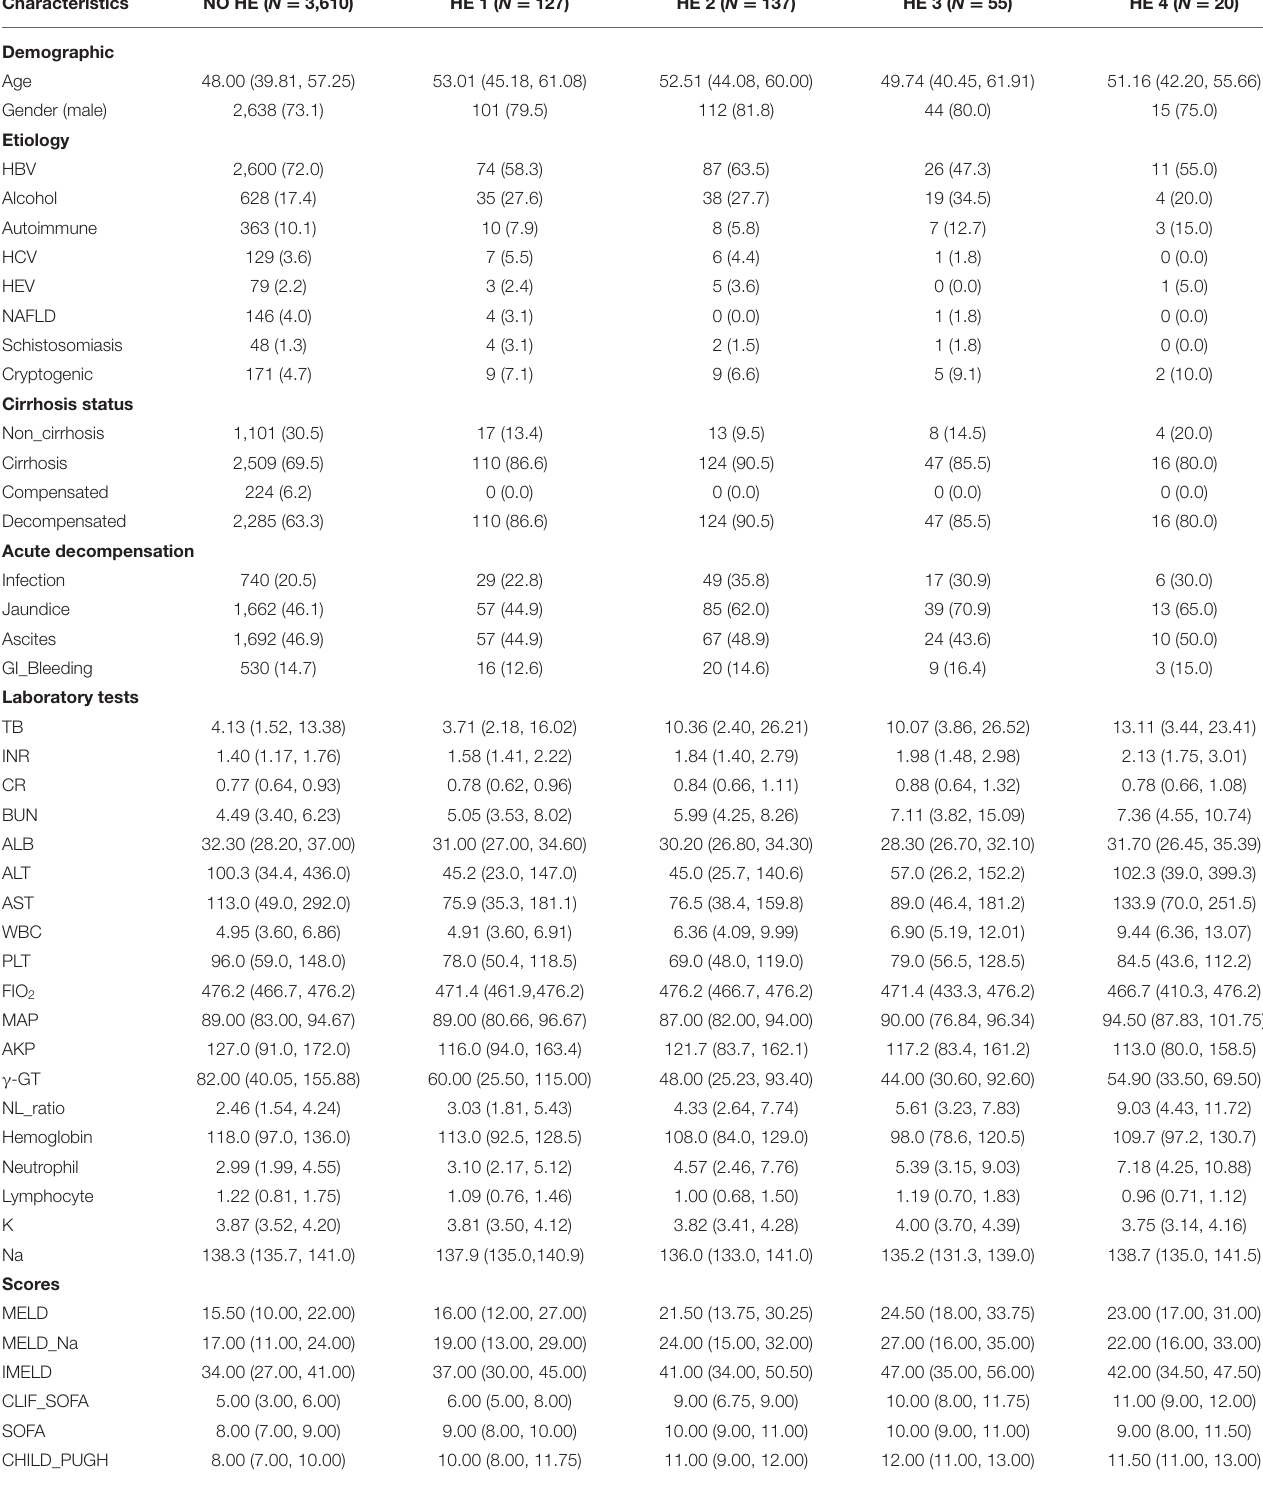
TABLE 1 | Association of HE grade with characteristics of AoCLD patients.